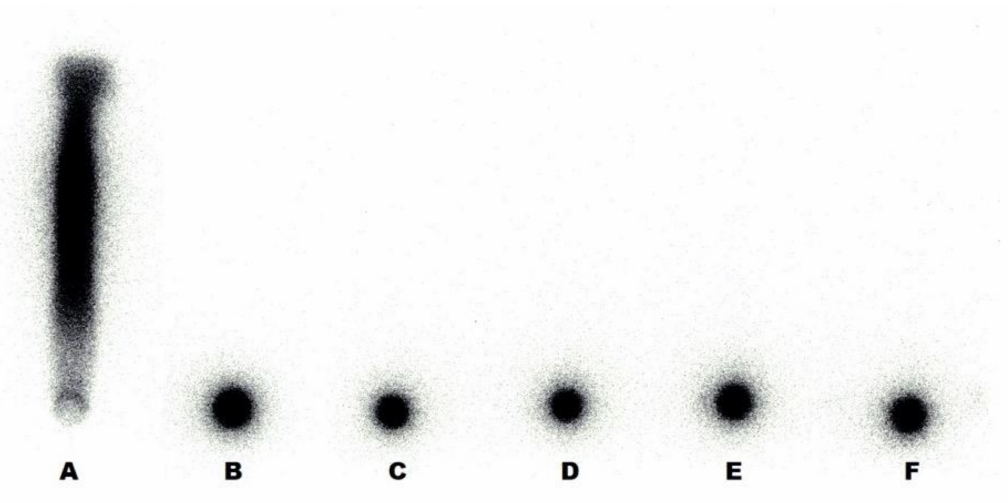
Figure 2. Instant thin-layer chromatography on silica gel impregnated glass fibres (ITLC-SG) radiochromatogram of 99m Tc-hydroxyethylidene diphosphonate ( 99m Tc-HEDP) and nanoparticles labeled with 99m Tc-HEDP. 99m Tc-HEDP ( A ), 99m Tc-PEG2000-HAP ( B ), 99m Tc-PEG5000-HAP ( C ), 99m Tc-POX5000-HAP ( D ), 99m Tc-POX10000-HAP ( E ) and 99m Tc-PHPMA5000-HAP ( F ).